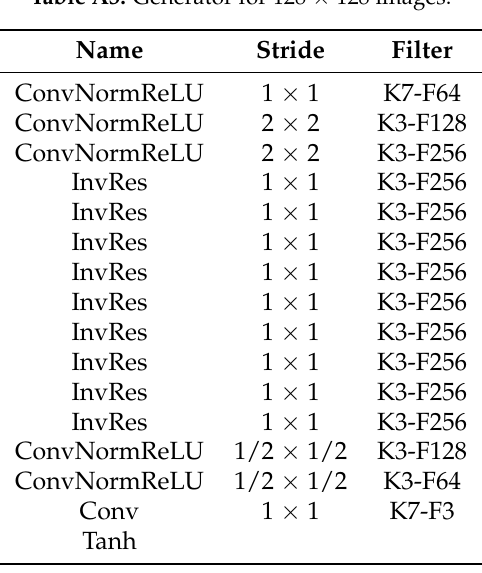
Table A3. Generator for 128 × 128 images.